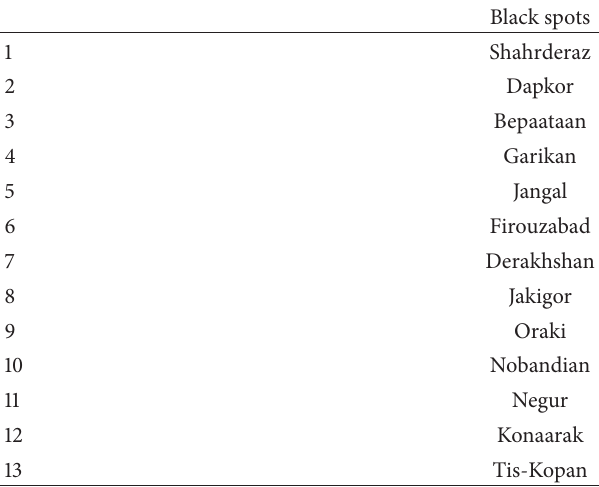
Table 12: Identification of black spots without using accident